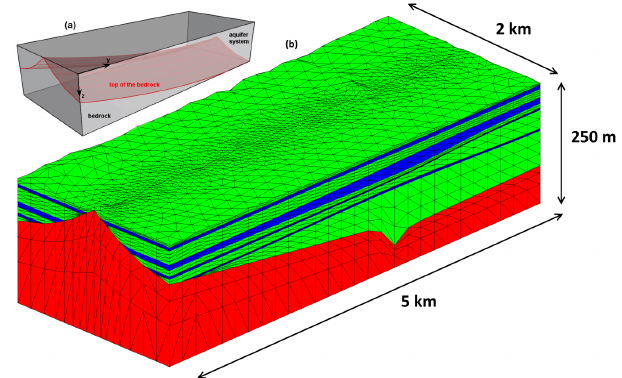
Figure 2. Test case 1: perspective views of the geological setting (a) and the 3-D FE-IE grid (b) . The materials are highlighted in various colours: rock in red, aquifers in blue, and aquitards in